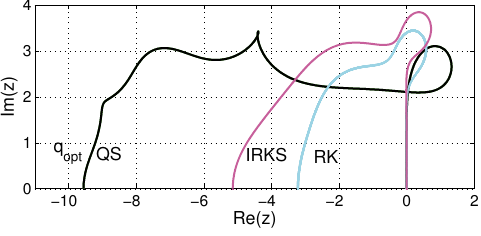
Figure 2. Stability regions of approximation of order p = 5 to exp( z ), of GLM with IRKS corresponding to η = 3 / 5, and of GLMs of order p = s − 1 = 5 with QS with residual = 9 · 10 − 10 . Stability region of optimal quadratic polynomial q opt cannot be distinguished from stability region of GLM with QS.